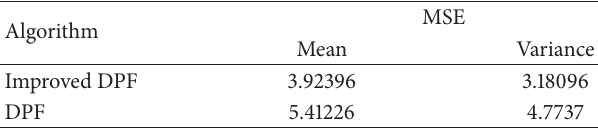
Table 2: The comparison of mean and variance in Experiment 2.